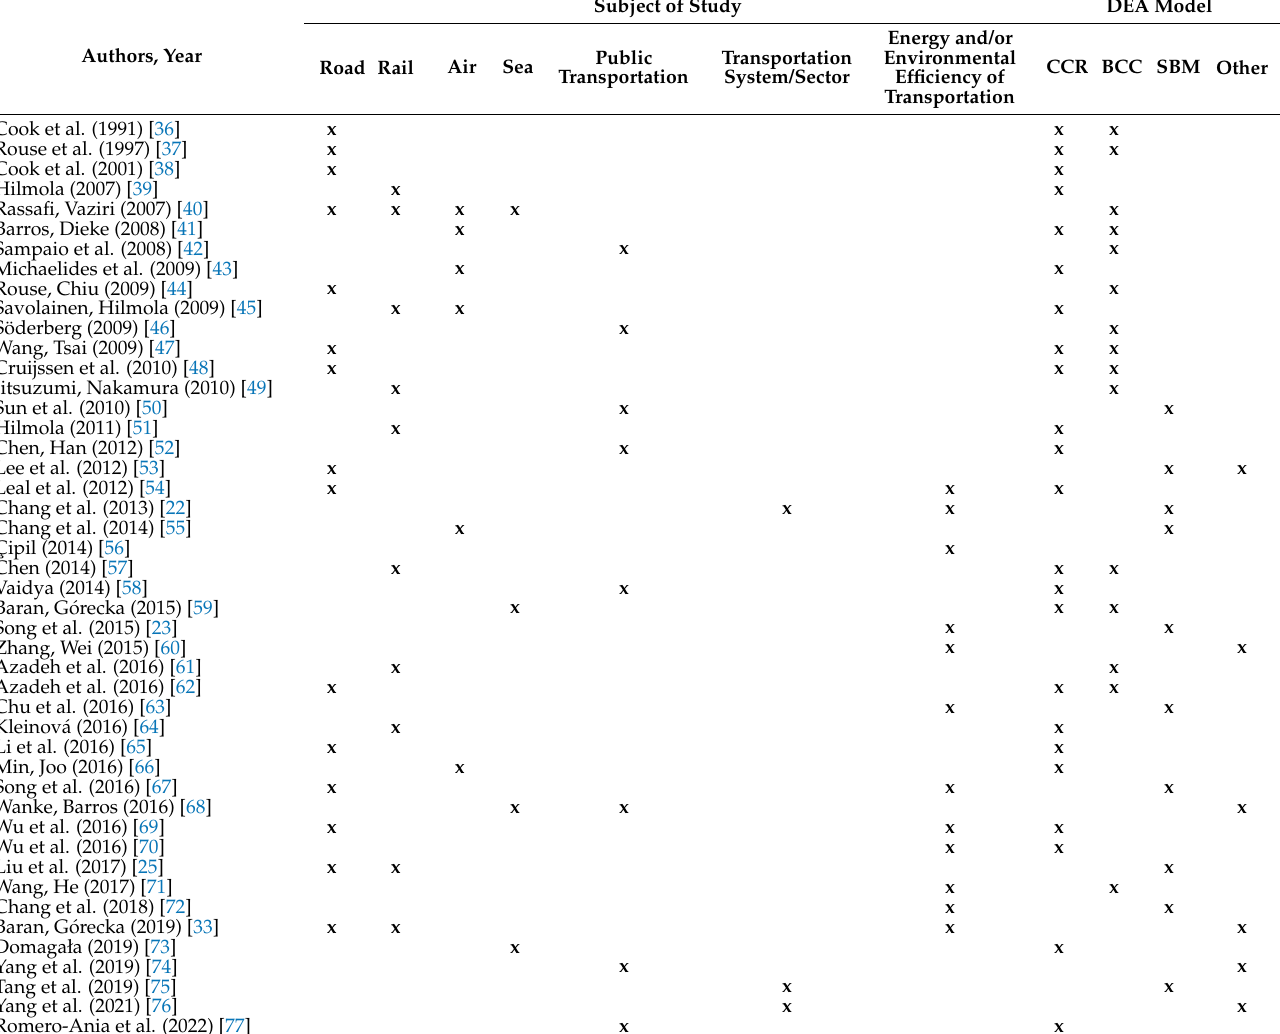
Table 2. Application of the DEA method in transport—a list of selected